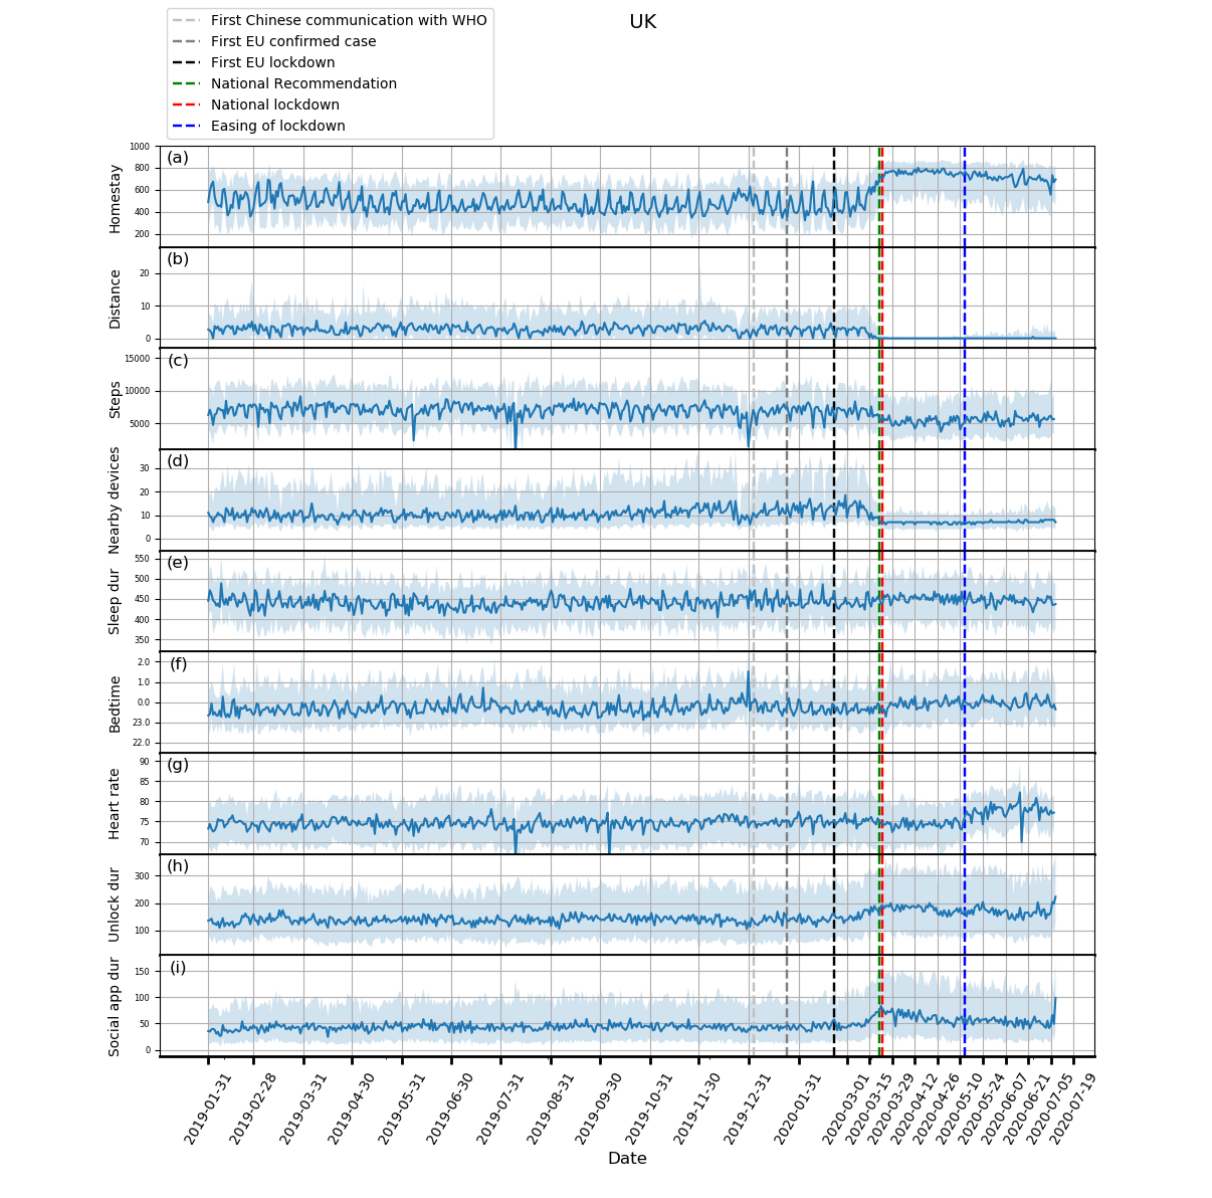
Figure 4. Behavioral changes for the United Kingdom (316 participants). (a) homestay duration, (b) maximum distance from home, (c) Fitbit step count, (d) maximum number of nearby devices, (e) total sleep duration, (f) bedtime, (g) heart rate, (h) unlock duration, (i) social app duration. Solid line: median; shade: 25th percentile to 75th percentile. dur: duration; WHO: World Health